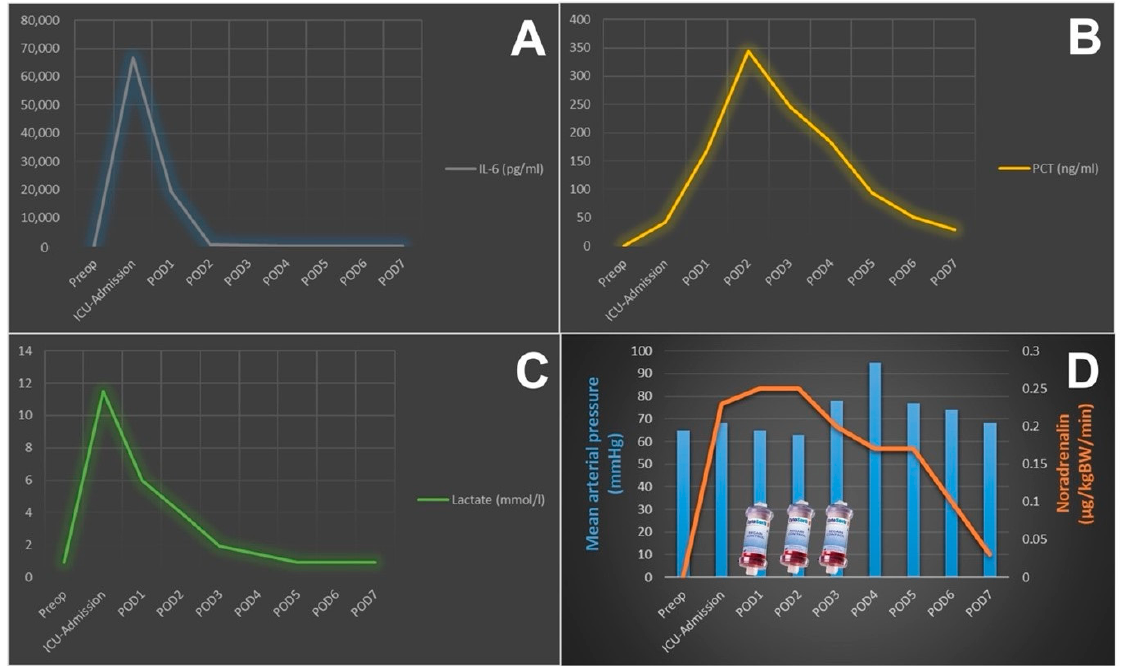
Figure 3. Postoperative course of inflammatory parameters, lactate, and vasopressor needs: ( A ) course of IL-6 (pg/mL), ( B ) Course of PCT (ng/mL), ( C ) Course of lactate (mmol/L), ( D ) Course of norepinephrine (µg/kgBW/min., orange line) and mean arterial blood pressure (blue bars) and three additional adsorber treatments on POD 1, 2 and 3.